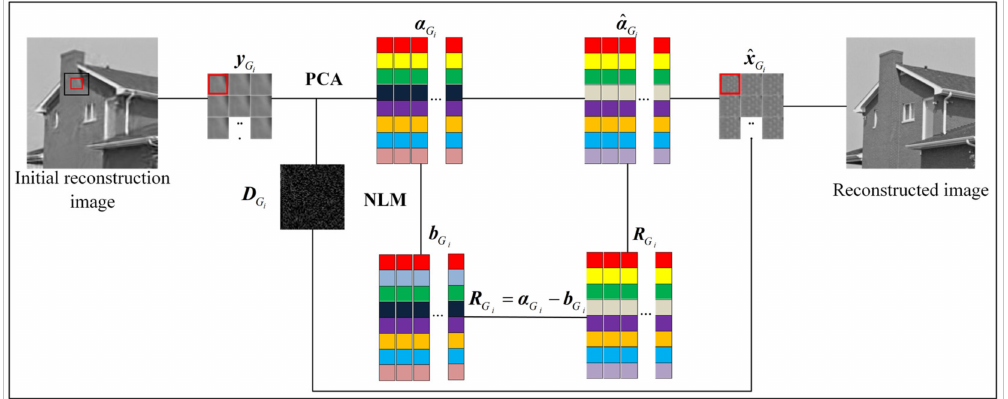
Figure 3. The complete flowchart of the optimized GSR-JR